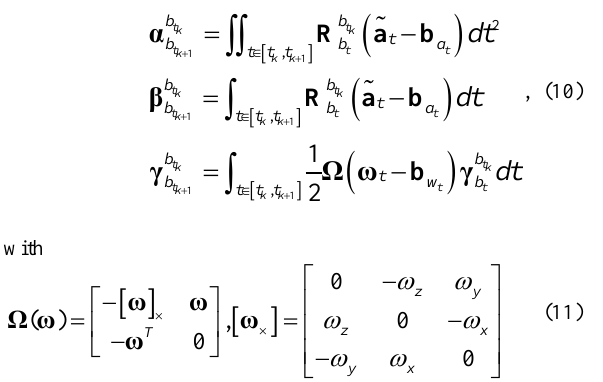
Figure 5 . Sensor configuration of AGV group